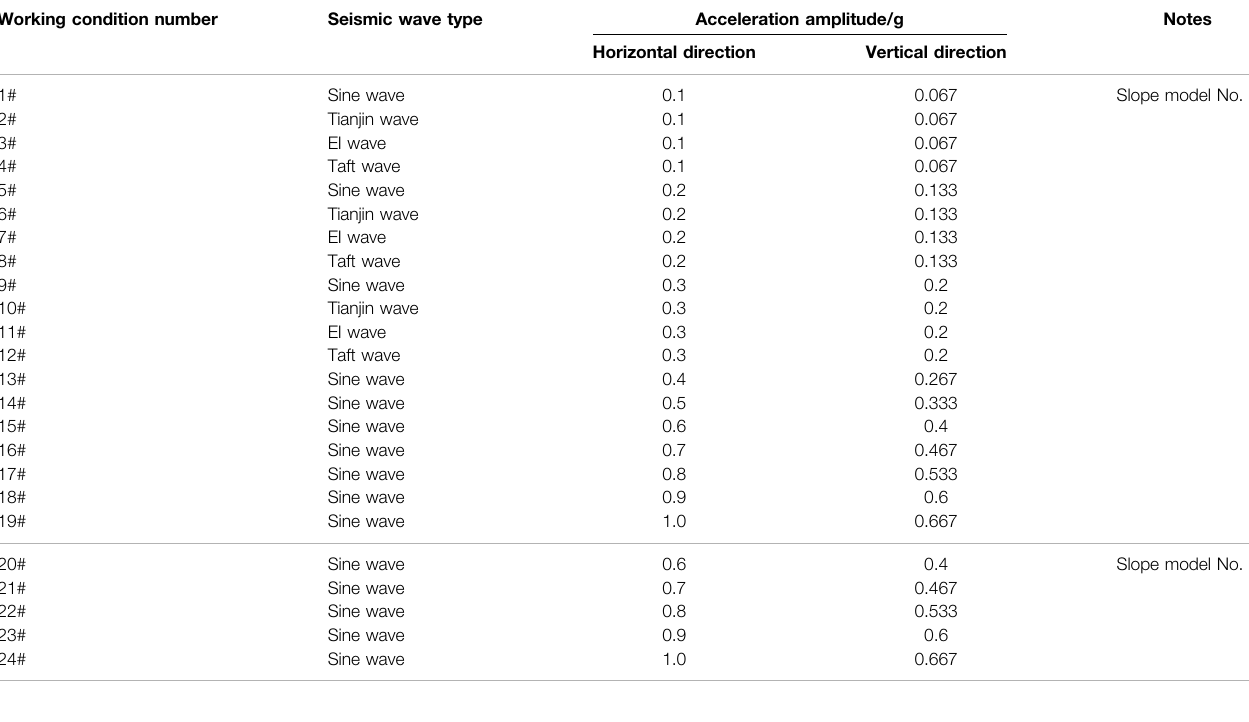
TABLE 2 | Loading scheme of model tests.